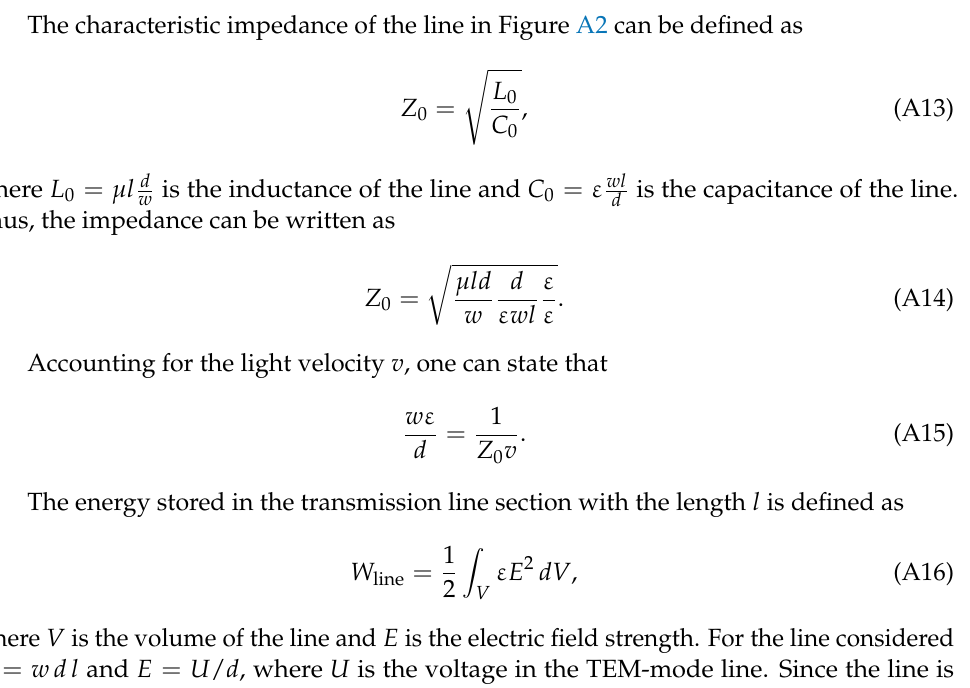
Figure A2. Cross-section of the simplest transmission